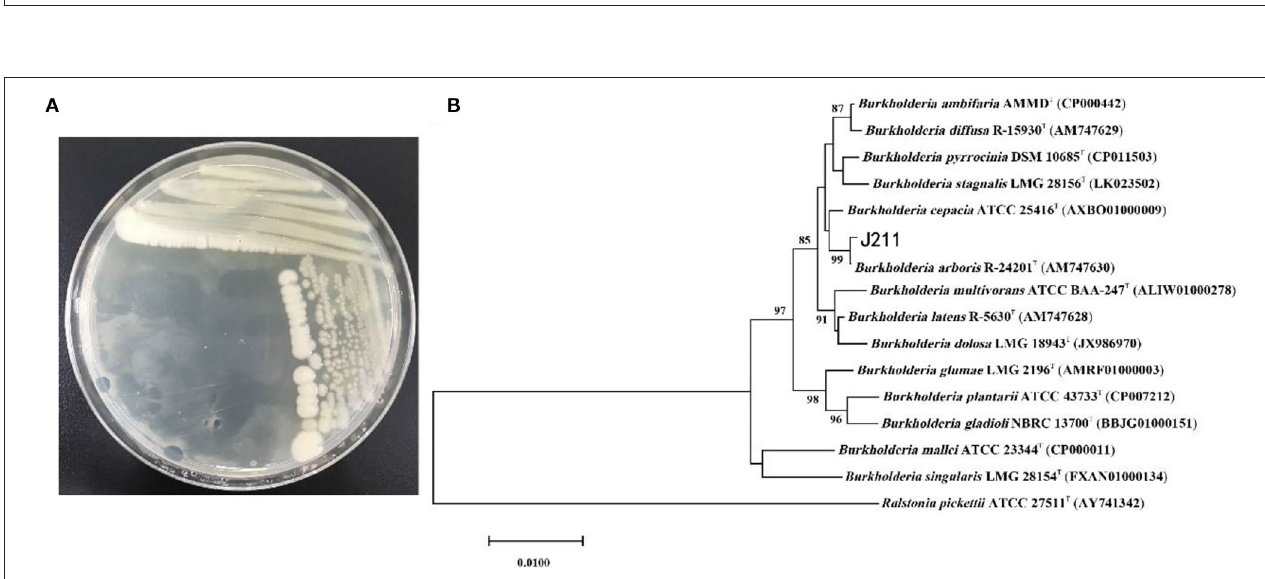
FIGURE 1 | The nematocidal activity of the culture filtrates from J211 against the J2s of M. incognita at different times. Values are means ± standard deviation of two runs with five replicates each (A) . Relationships among means were analyzed by one-way ANOVA and Duncan’s multiple-range test ( P < 0.05). Means with the same letter did not differ significantly. Nematodes activity shows control, curved are vigorous (B) ; the antagonistic stiff died and have no vitality (C) after 24h. Bar: 500 µ m.